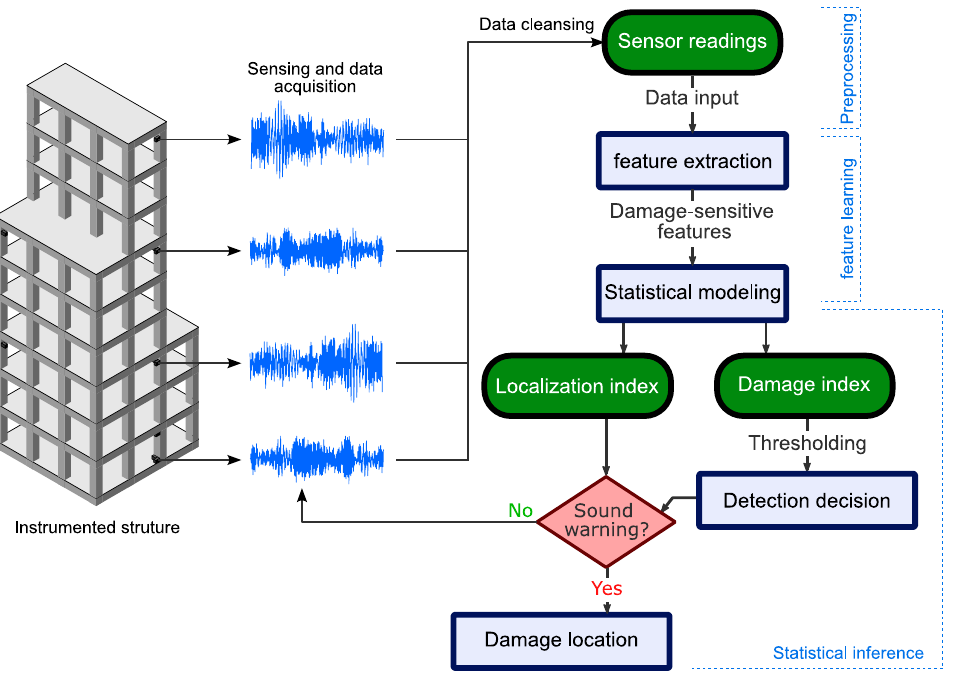
Figure 1. An example flowchart of a data-driven structural damage detection system.